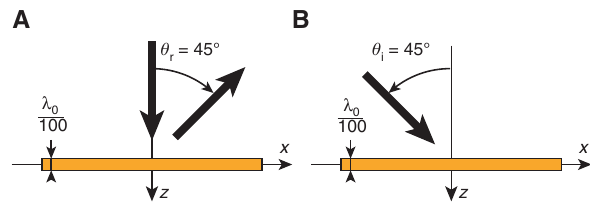
Figure 4: Example of double-transformation metasurface: (A) first transformation [corresponding to subscript 1 in Eq. (38)]: the normally incident plane wave is fully reflected at a 45 ° angle and (B) second transformation [corresponding to subscript 2 in Eq. (38)]: the obliquely incident plane wave is fully absorbed.